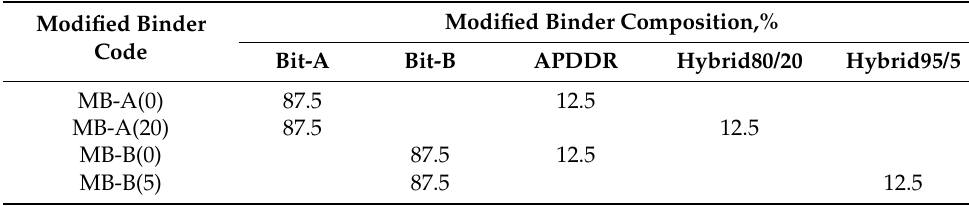
Table 3. The coding and composition of modified binder